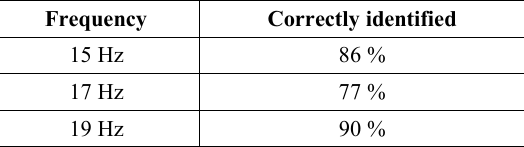
Fig. 6. Blinking module used in tests.